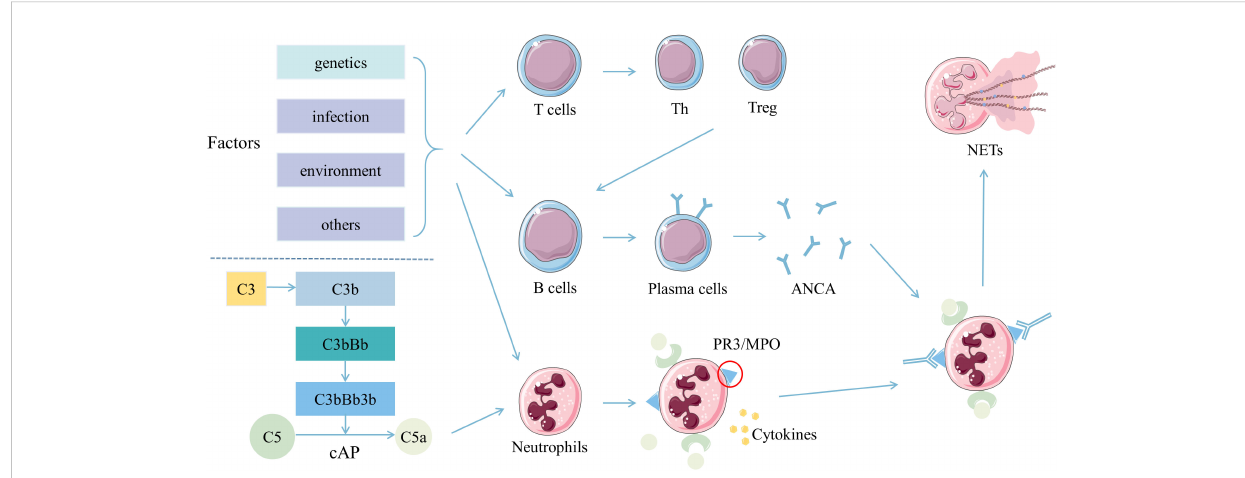
FIGURE 1 Pathogenesis of ANCA associated vasculitis. T cells, B cells, and neutrophils were activated by multiple stimulations in the background of genetic susceptibility. Th and Treg cells differentiated from T cells synergistically promote B cells to develop into plasma cells, and produce ANCA. ANCA then combined with PR3 or MPO expressed on neutrophils pre-activated by in fl ammatory cytokines. Also, C5a derived from activated cAP might combine with the C5a receptor on neutrophils. Neutrophils activated by ANCA, C5a and various cytokines might produce more NETs conducive for the in fl ammatory response and adaptive immunity, ultimately leading to clinical damages. Abbreviations: ANCA, anti-neutrophil cytoplasmic autoantibodies; C5a, fragment a of the fi fth complement; cAP, complement alternative pathway; MPO, myeloperoxidase; NETs, neutrophil extracellular traps; PR3, proteinase-3; Th, helper T; Treg, regulatory